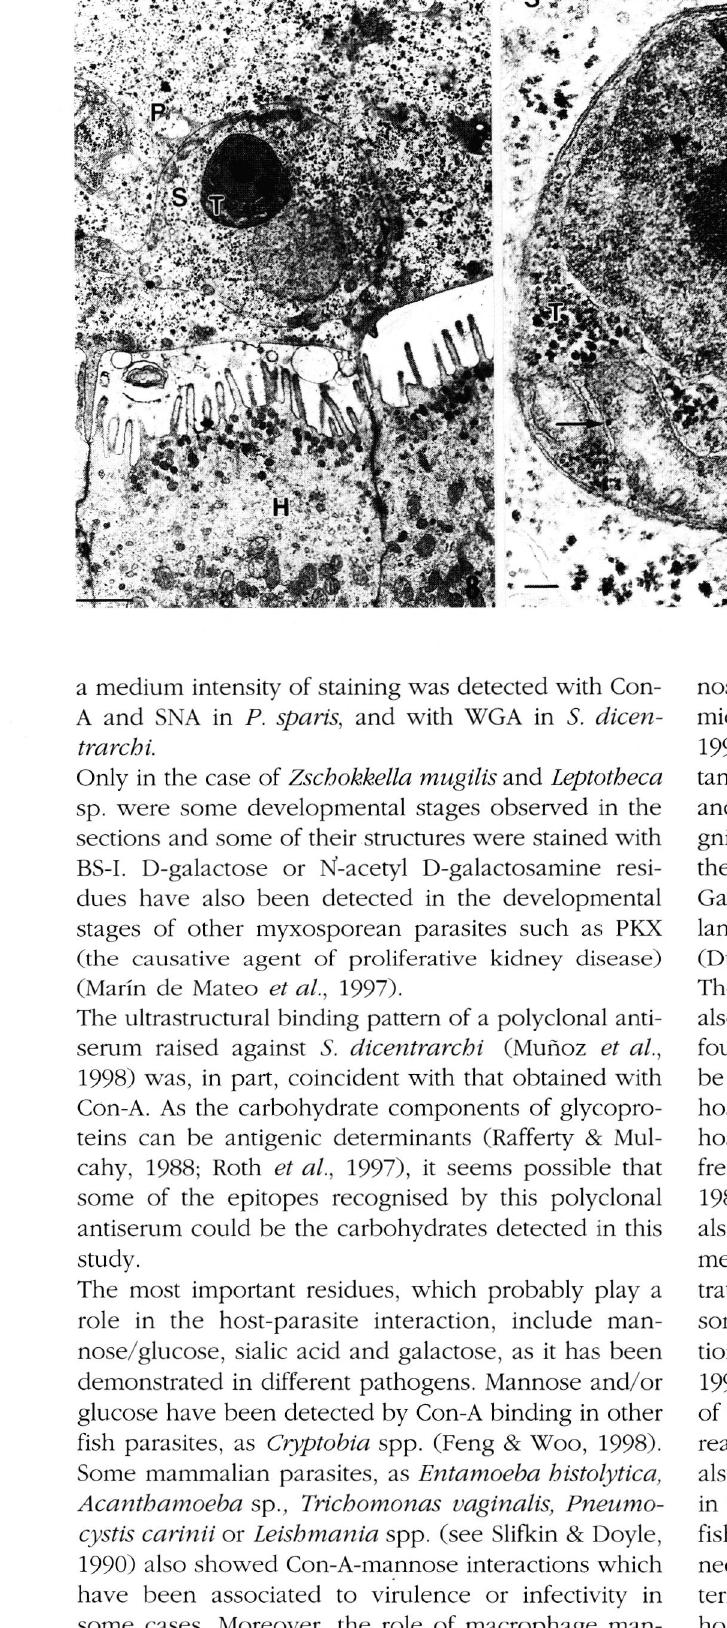
Figs. 8, 9. - Transmission electron microscopy images of Zschokkella mugilis in a mullet gall bladder sec tion stained with BS-I. Fig. 8. - Pri mary cell (P) attached to the epi thelium of the host (H), containing secondary (S) and tertiary (T) cells. Bar = 1 µm. Fig. 9. - Detail of these S and T cells showing the scarce labelling in the cytoplasm and mitochondria (arrows) and some staining in the nucleus (arrow heads). Bar = 0.1